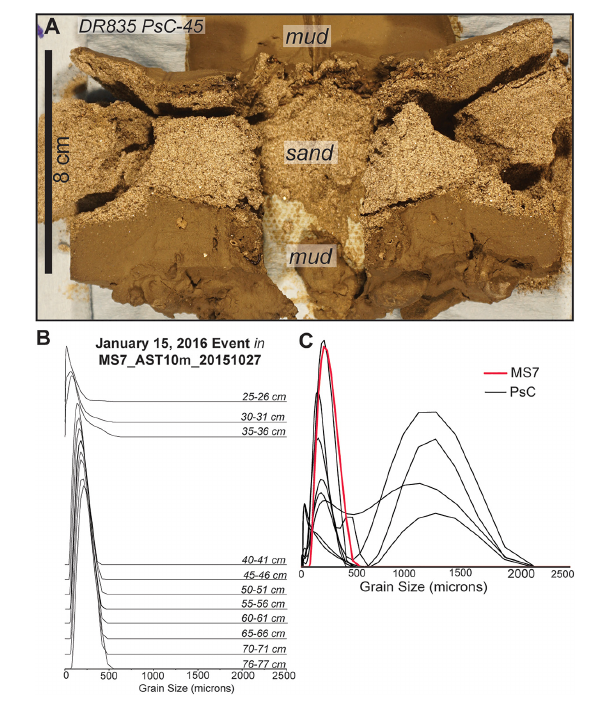
FIGURE 10 | Comparison of sediment from the January 15, 2016 sediment density flow event in MS7 trap and seabed samples. See Figure 1B for sample locations. (A) Photograph of an extruded and split pushcore acquired following the January 15, 2016 event. (B) Stratigraphy of grain-size distributions from the January 15, 2016 event unit in MS7 sediment trap at 10 masf. (C) Comparison of grain-size distributions from MS7 and